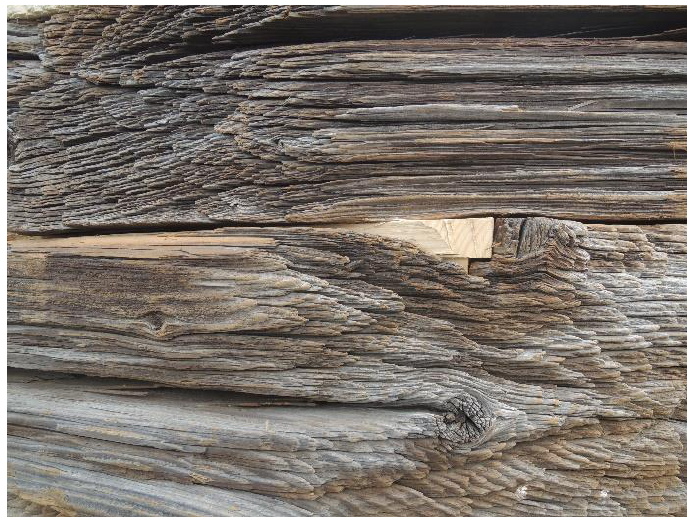
Figure 26. The repaired beam put back to its original place in the barn timber wall (outside view).